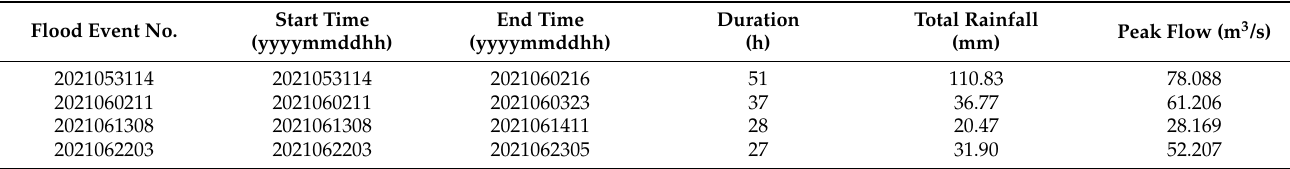
Table 4. Information on the studied flood